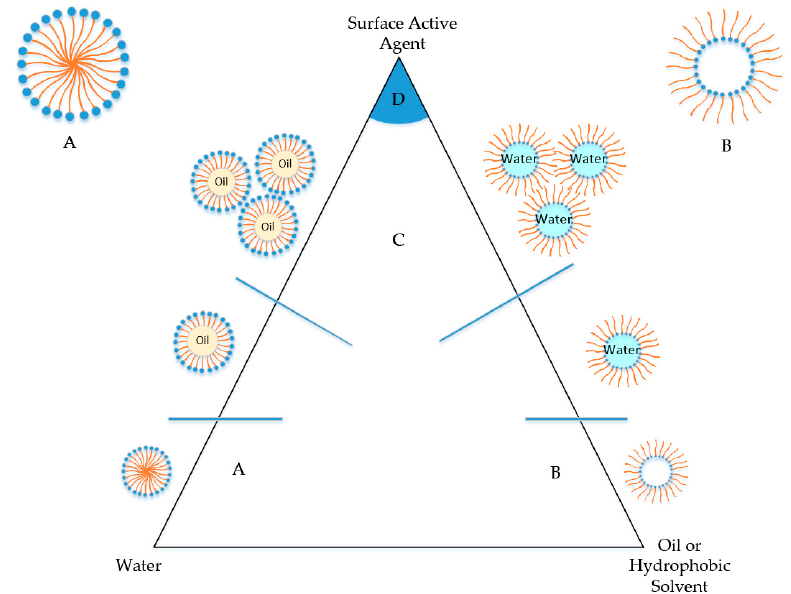
Figure 3. Phase diagram of an oil–water–surface-active agent microemulsion system, where shaded areas represent multiphase regions, modified from [67]. ( A ) Normal micelles: oil-in-water microemulsions in water (modified from [56]); ( B ) Reverse micelles: water-in-oil microemulsions in oil or water which is heavily dominated by hydrophobic compounds (modified from [56]); ( C ) concentrated microemulsion domain; and ( D ) liquid-crystal or gel phase.